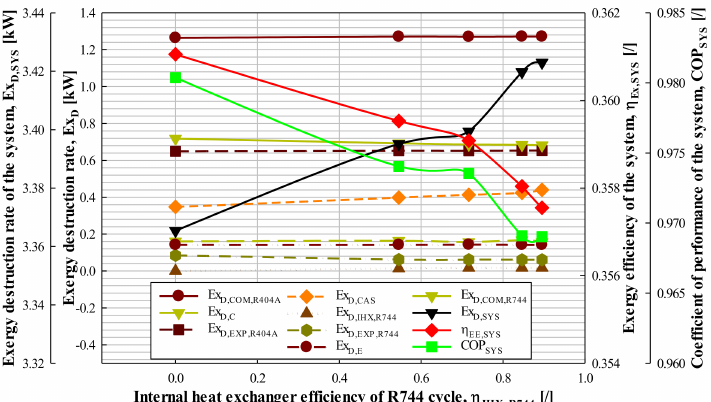
Figure 11. Exergy destruction rate, exergy efficiency and COP of the CRS with respect to the IHE efficiency of the R744